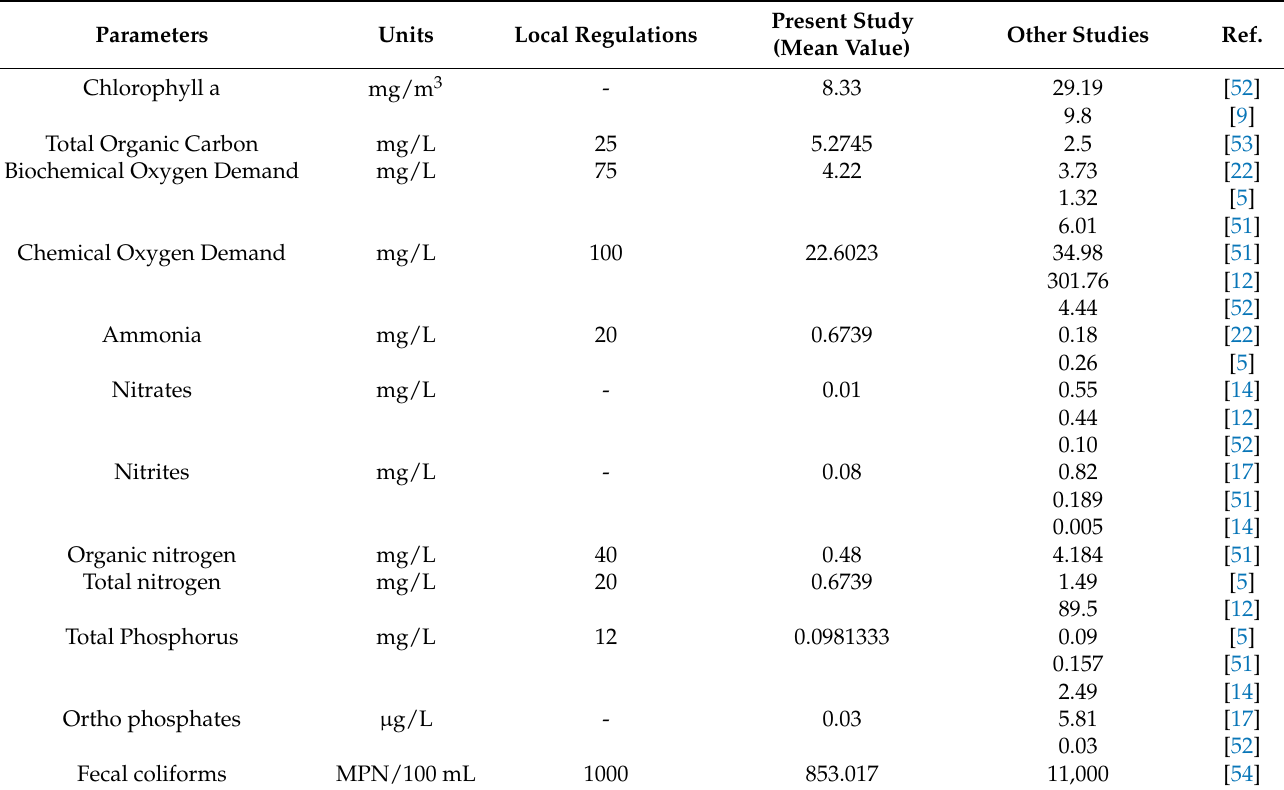
Figure 3. Box-and-whisker plots for water quality parameters at the 4 sampling points. Table 1. Permissible limits of water quality parameters from local standards and comparison with other